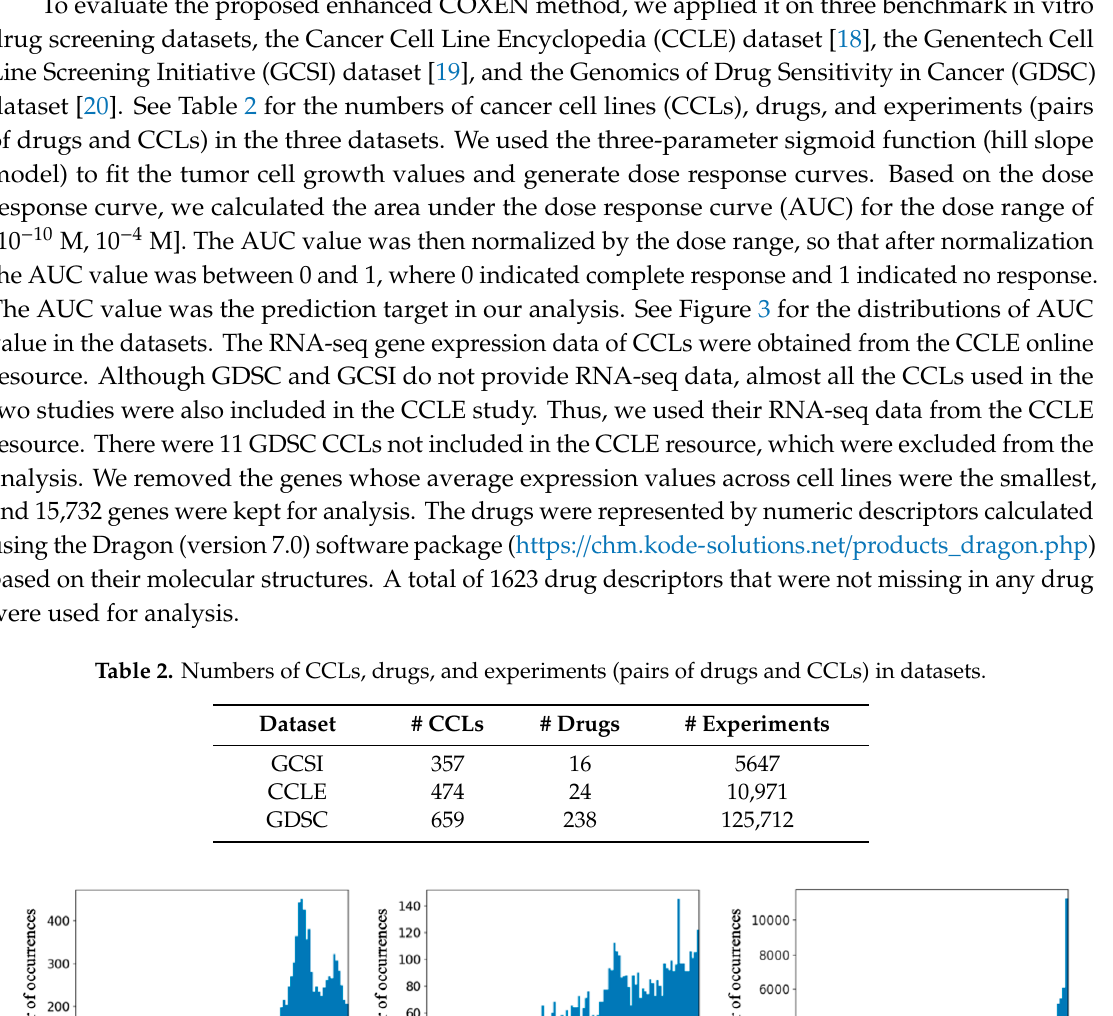
Table 2. Numbers of CCLs, drugs, and experiments (pairs of drugs and CCLs) in datasets .